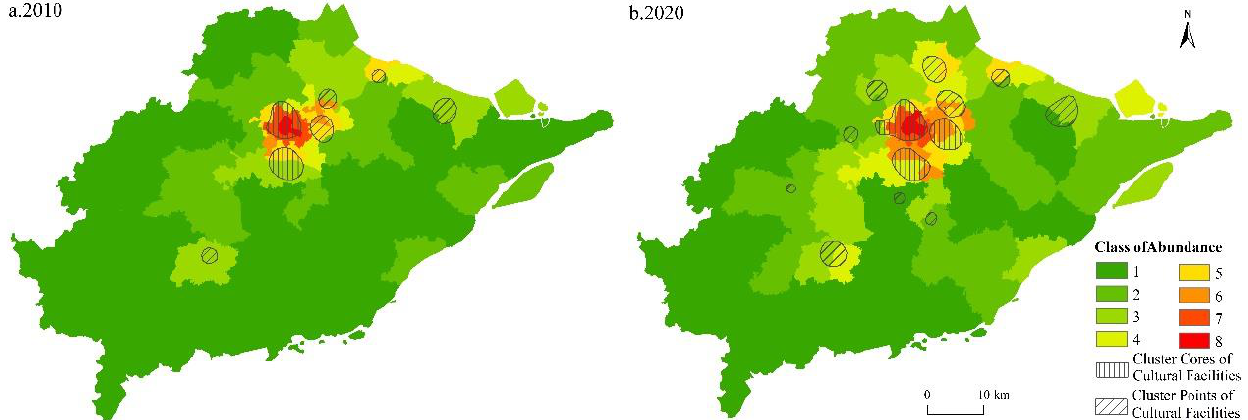
Figure 7. The spatial superposition of agglomeration area of cultural facilities and the abundance of cultural enterprises in the central district of Ningbo in ( a ) 2010 and ( b ) 2020. Note: This map is based on the standard map of the Map Technical Review Centre of the Ministry of Natural Resources of China (Number: Zhejiang S (2022)34), with no modifications to the base map. Map-making by the author.